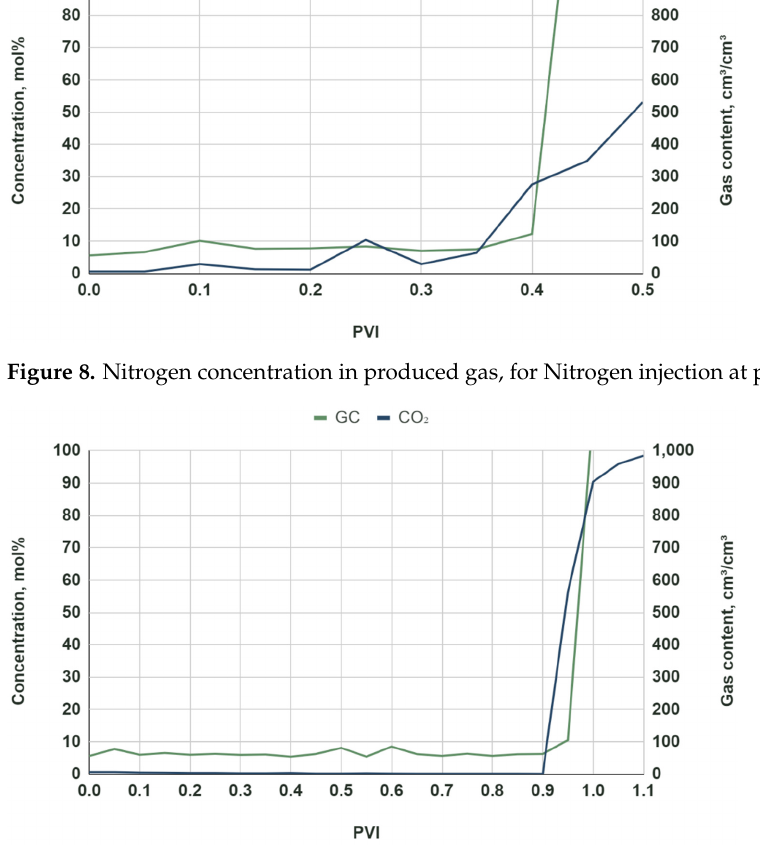
Figure 9. CO 2 concentration in produced gas, for CO 2 injection at a pressure of 40 MPa.